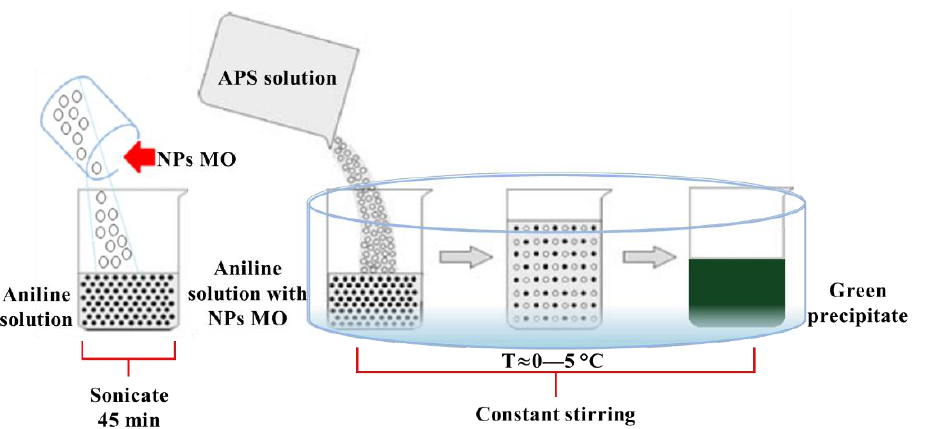
Figure 2. Schematic representation of SiO 2 , TiO 2 , and CeO 2 -PANI nanocomposites synthesis by in situ chemical oxidative polymerization by rapid mixing.